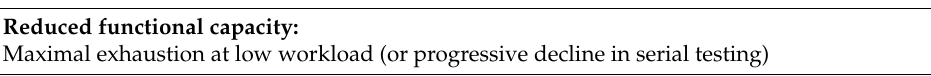
Table 2. Cont. Sustained tachyarrhythmias: Progressive ventricular arrhythmias >3